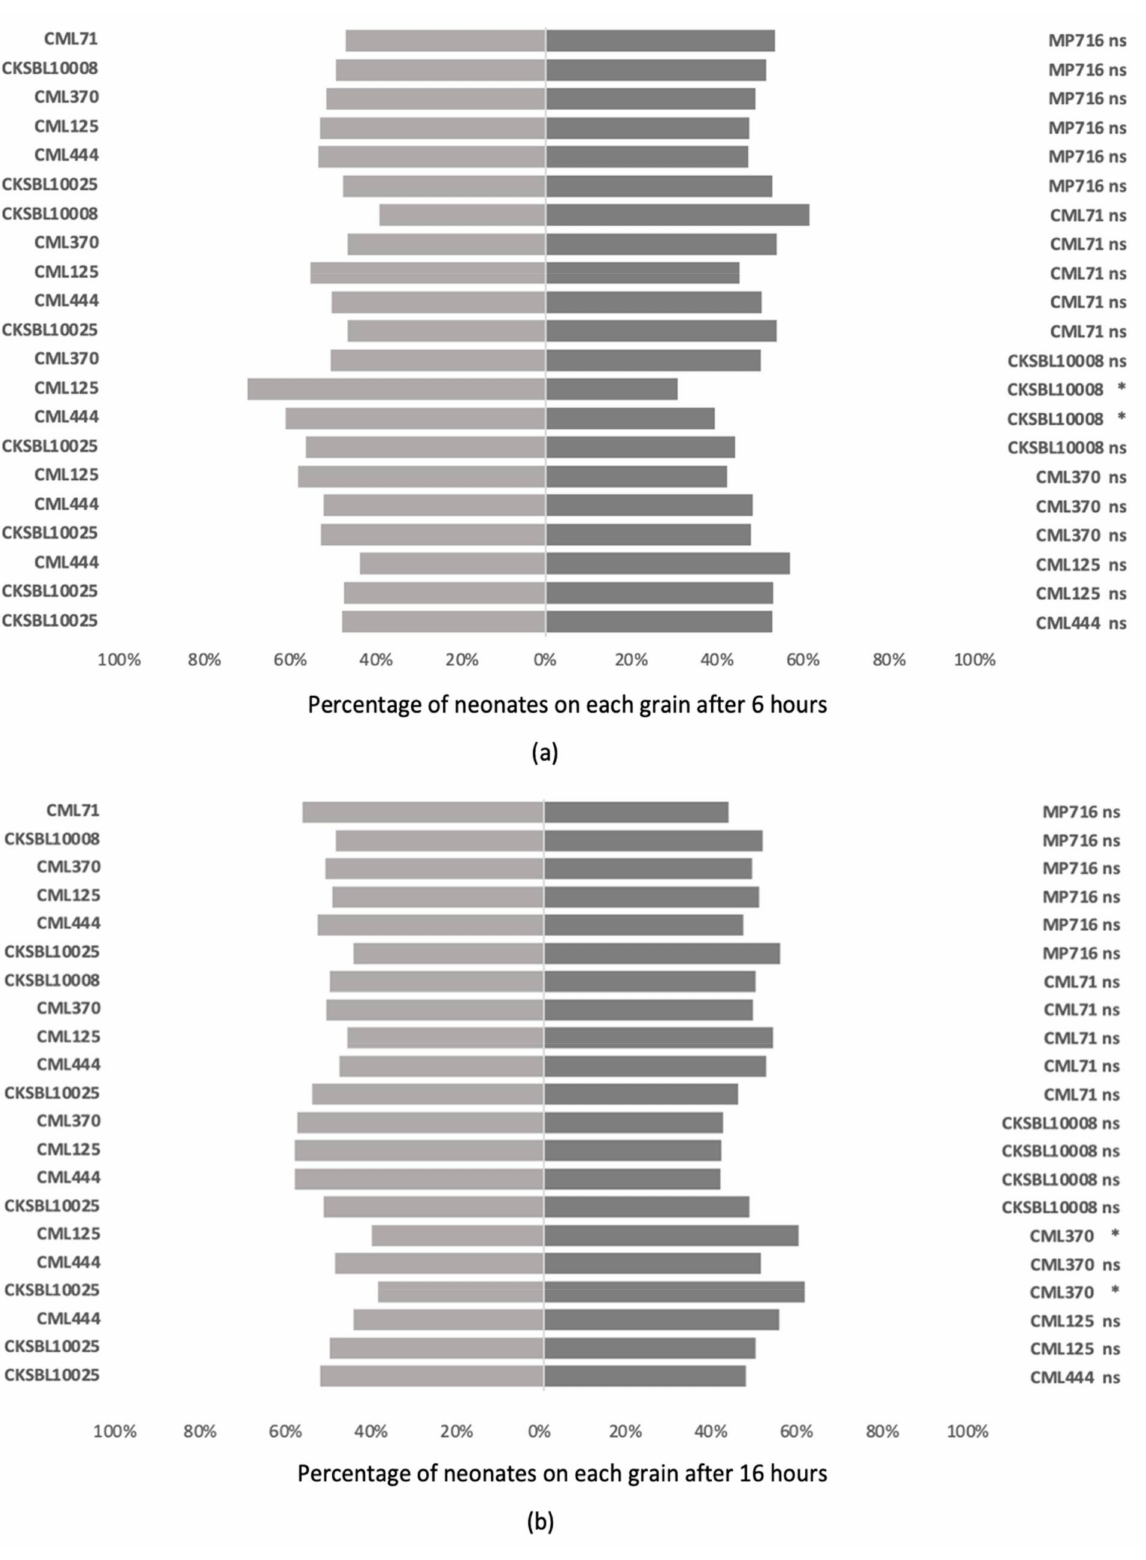
Figure 5. Mean percentage of Spodoptera frugiperda neonates found on grain of each inbred line under binary choice conditions after 6 ( a ) (n = 20) and 16 ( b ) (n = 24) hours of bioassay between maize inbred lines in a Petri dish. Asterisks (*) represent significant differences and (ns) represent no significant differences at 5% probability level (Wilcoxon rank sum